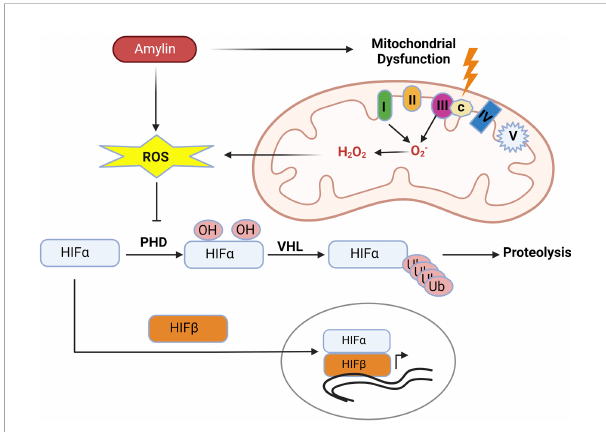
FIGURE 5 Human amylin induced mitochondrial dysfunction promotes hypoxia. Human amylin induced mitochondrial dysfunction increases production of mtROS which inhibits the activity of PHDs allowing for stabilization of HIF-1 a subunits and HIF mediated